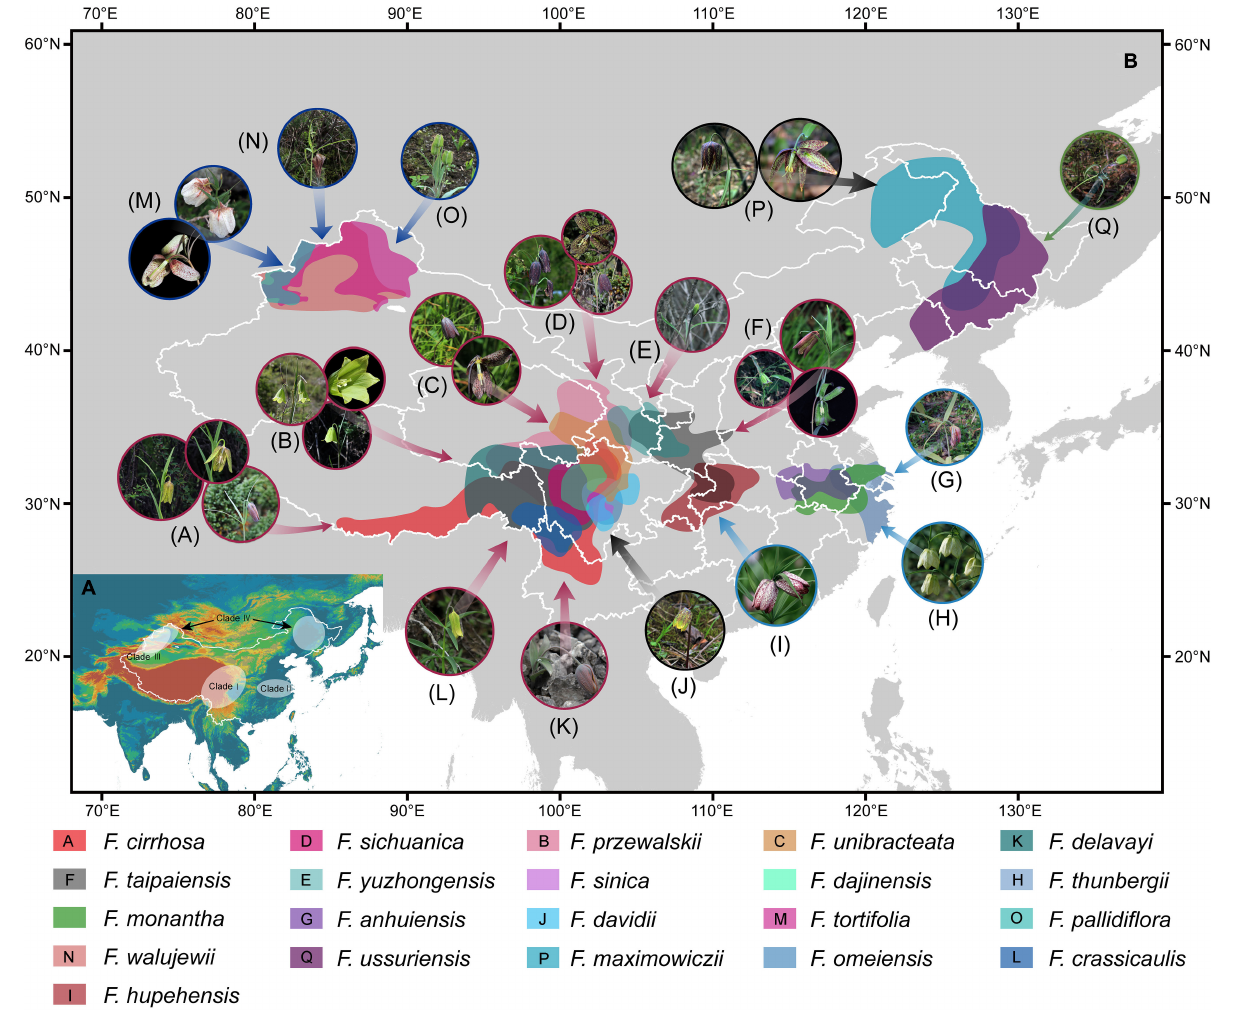
FIGURE 7 | Four major clades of the subgenus Fritillaria in geography (A) and the potential geographical distributions of the 21 Fritillaria species predicted using the MaxEnt model with all records of existing vouchers of corresponding species (http://www.cvh.ac.cn/ and http://www.papc.cn/) (B) . Photos represent living plants of Fritillaria species as follows: (A) F. cirrhosa , (B) F. przewalskii , (C) F. unibracteata , (D) F. sichuanica , (E) F. yuzhongensis , (F) F. taipaiensis , (G) F. anhuiensis , (H) F. thunbergii , (I) “ F. hupehensis ,” (J) F. davidii , (K) F. delavayi , (L) F. crassicaulis , (M) F. tortifolia , (N) F. walujewii , (O) F. pallidiflora , (P) F. maximowiczii , and (Q) F. ussuriensis